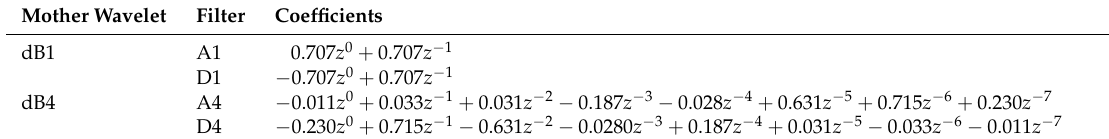
Table 1. DWT z domain FIR filter coefficients (to three decimal places; A: approximation; D: details). Mother